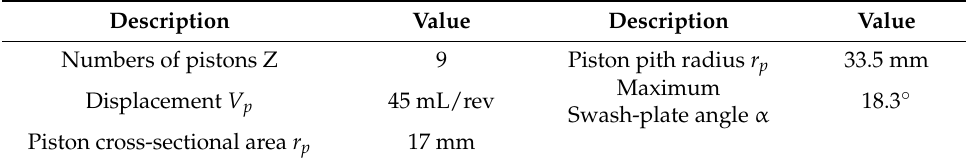
Table 2. Model’s main geometric parameters in the work of